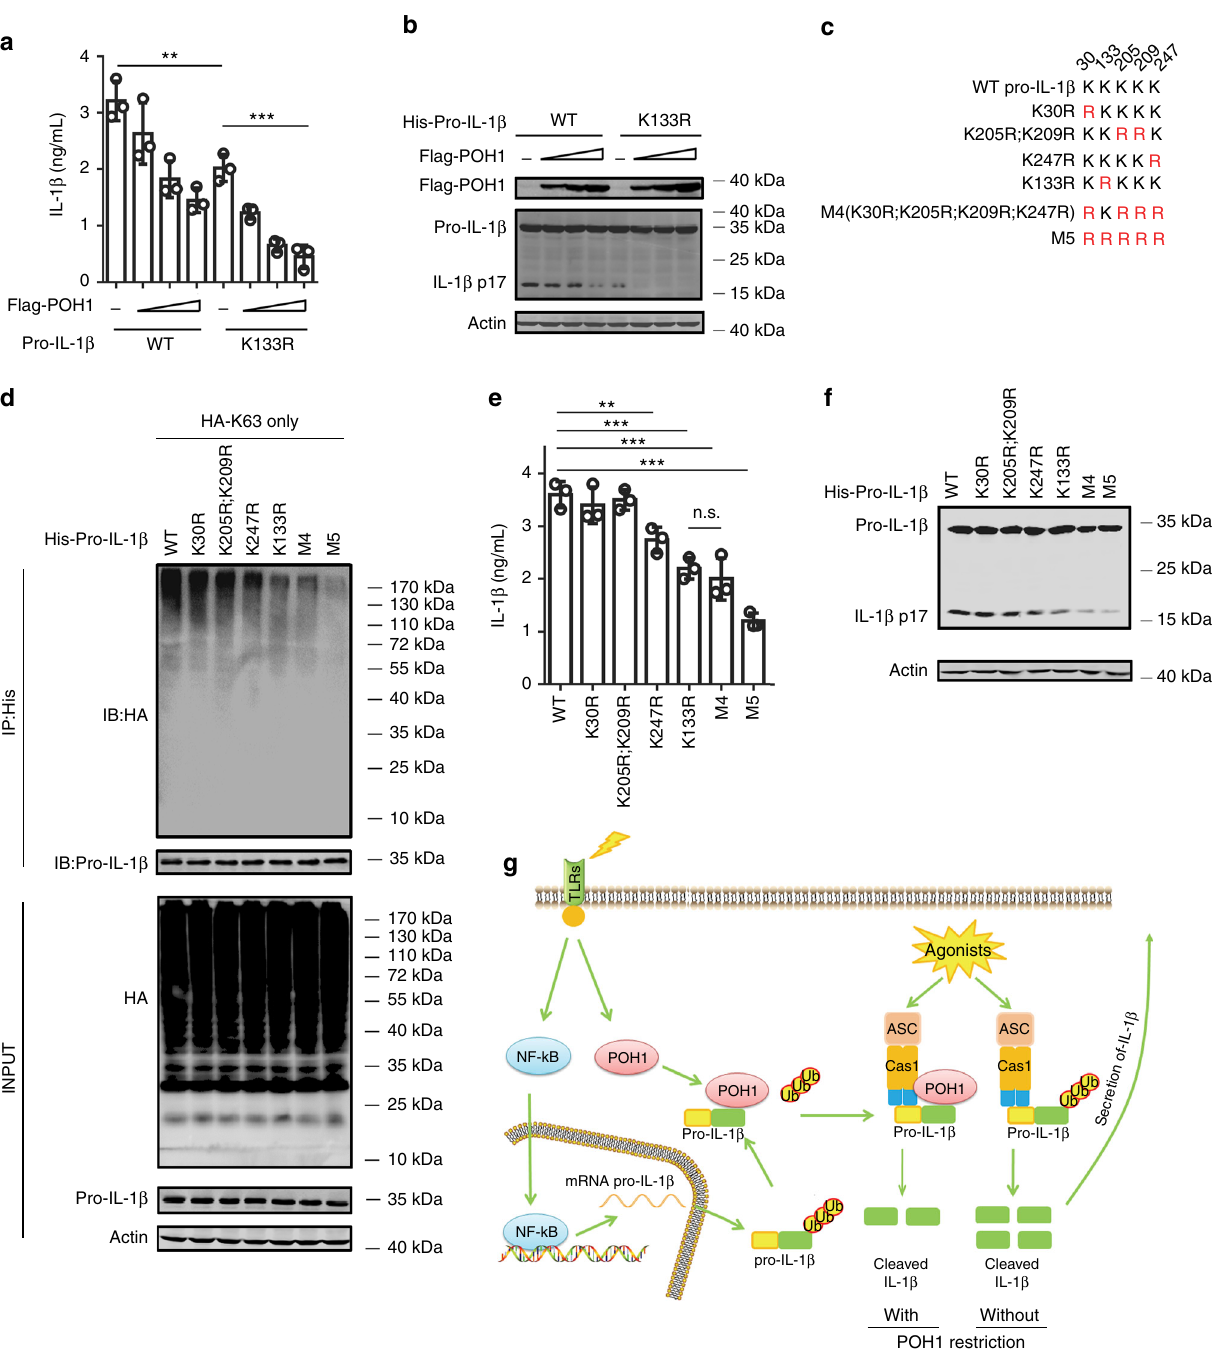
Fig. 6 Pro-IL-1 β maturation is regulated by POH1-mediated deubiquitination. a , b HEK293T cells were transfected with plasmids encoding Flag-caspase-1, Vsv-ASC, His-pro-IL-1 β (WT) or His-pro-IL-1 β -K133R with different amounts (125, 250, 500 ng) of plasmid encoding Flag-POH1 and 500 ng of control plasmid, the secretion of a IL-1 β in the supernatants was quanti fi ed by ELISA 36 h after transfection; b the cell lysates were IB with the indicated antibodies. c Mutants of murine pro-IL-1 β with replacement of various lysine residues. d-f HEK293T cells were transfected with Flag-POH1, V5-caspase-1, V5-ASC, His-pro-IL-1 β (WT) or its mutants, along d with or e-f without HA-tagged K63-only Ub, then d cells were subjected to IP with an anti-His antibody and IB with the indicated antibodies. e The IL-1 β levels in supernatants were measured by ELISA; or f the cell lysates were collected and IB with the indicated antibodies. g Proposed function of POH1 as a negative regulator in mediating IL-1 β processing. POH1, upregulated by TLR3/4 activation, interacts with and deubiquitinates pro-IL-1 β , resulting in restriction of IL-1 β cleavage and secretion. Similar results were obtained from three independent experiments. The results represent the mean ± s.d. of three independent sets of experiments. ** p < 0.01, *** p < 0.001 (one-way ANOVA with Tukey ’ s post-hoc